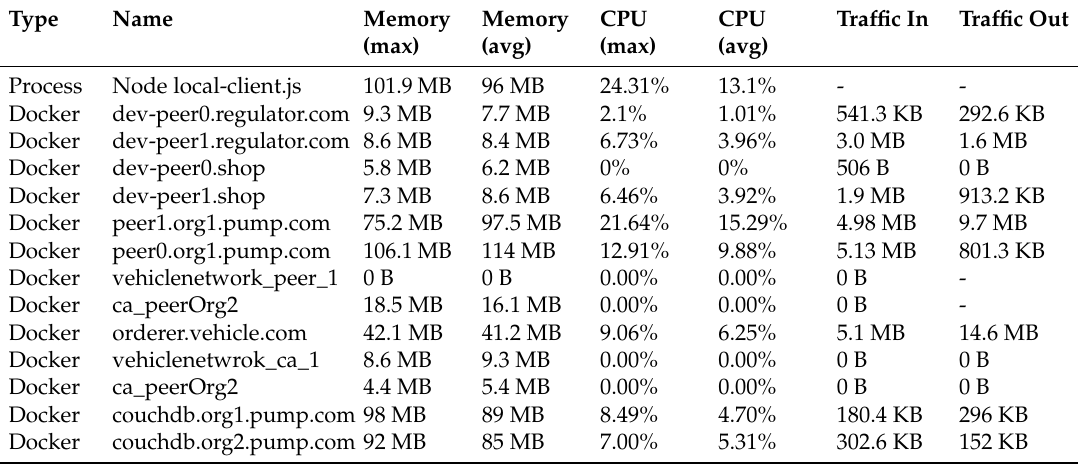
Figure 15. Get request transaction latency evaluation. Table 4. Resource utilization analysis of proposed